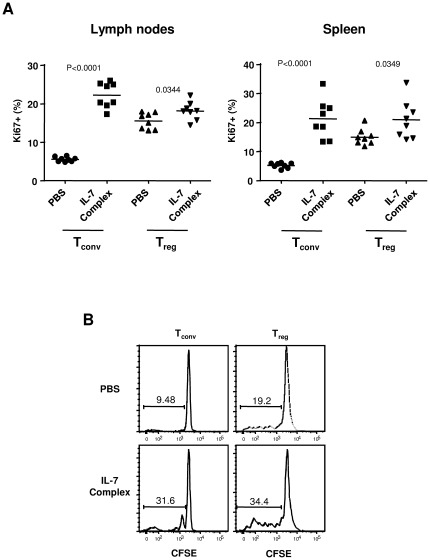
IL-7 mildly impacts CD4+CD25+ Treg cells proliferative capacity.Unmanipulated C57Bl/6 mice (A) or C57Bl/6 mice transferred with CFSE labeled total CD45.1 CD4 T cells (B) were i.p. injected with PBS or IL-7/anti-IL-7 complexes (1 µg rmIL-7 plus 5 µg M25) three times at 2 day intervals. (A) Percentage of cells expressing the proliferation marker Ki67 in CD4+ TCRβ+FOXP3− conventional T cells and CD4+ TCRβ FOXP3+ regulatory T cells from LN (left panel) and spleen (right panel). Percentage of Ki67 positive cells were determined based on isotype control. Results were pooled from 2 separate experiments, using three to four mice per group. (B) Representative CFSE profiles of CD45.1 Tconv and Treg isolated at day 7 from PBS or IL-7 complexes treated mice. Experiments were repeated independently three times with two to four mice per group. Data shown are representative of one experiment.